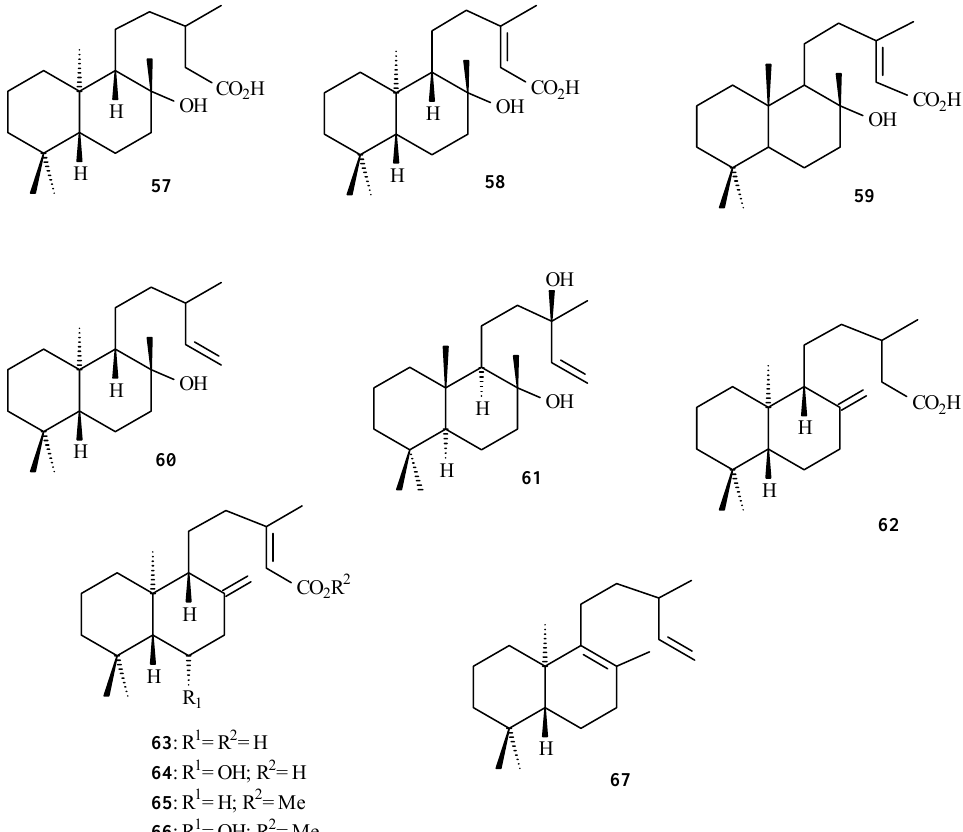
Figure 7. Labdane diterpenoids isolated from Aristolochia species.